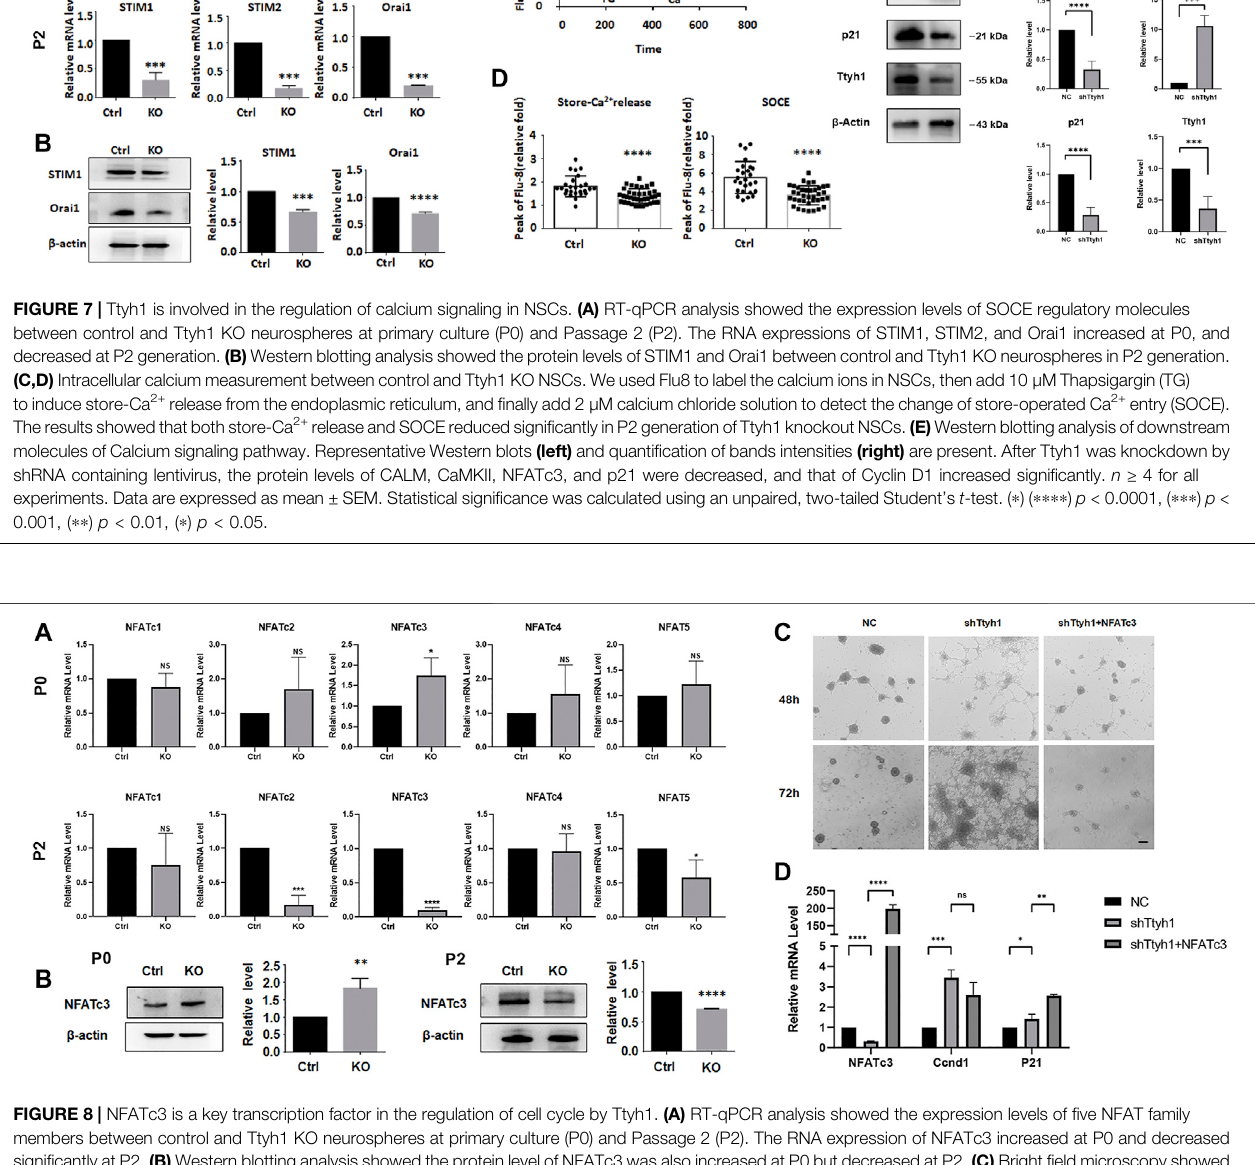
Frontiers in Cell and Developmental Biology |